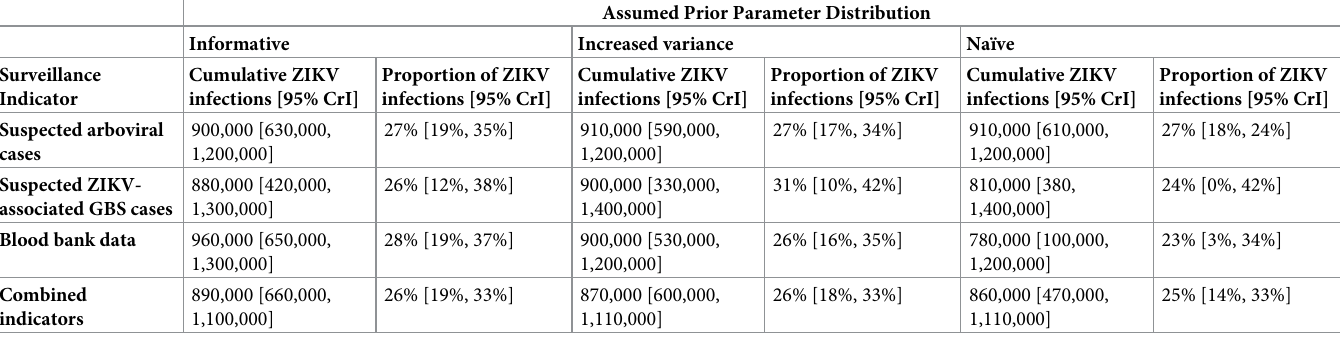
Table 2. Estimated cumulative Zika virus (ZIKV) infections from models using informative, na ï ve, and increased variances for prior distributions, Puerto Rico, 2016.